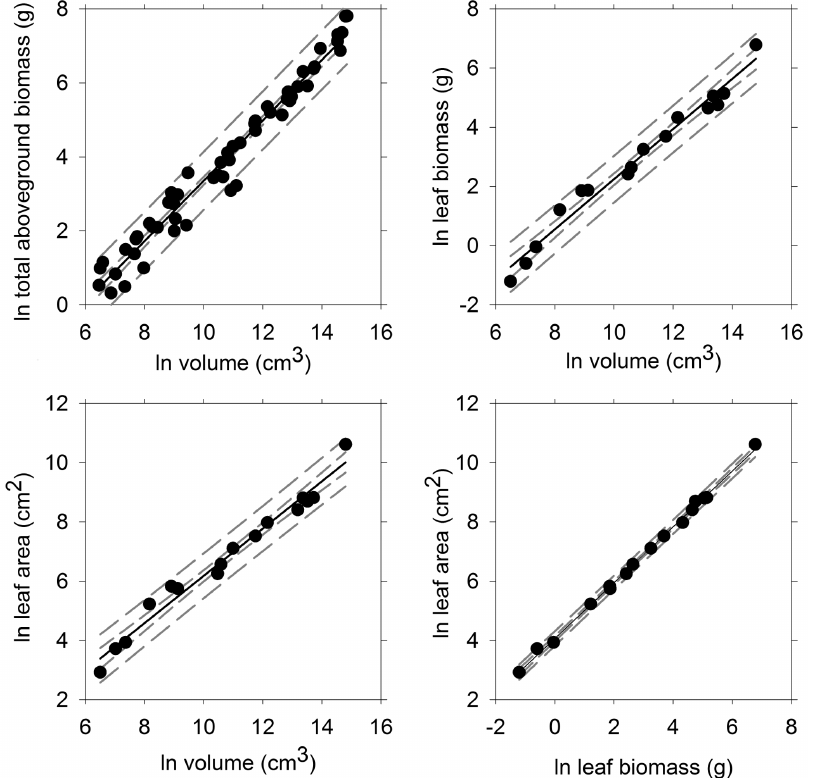
Figure 3. Aboveground allometric relationships for freeze-affected black mangrove ( Avicenniagerminans ) individuals. The short and long dashed lines show the 95% confidence and prediction bands, respectively. Note the natural log scale on both axes.